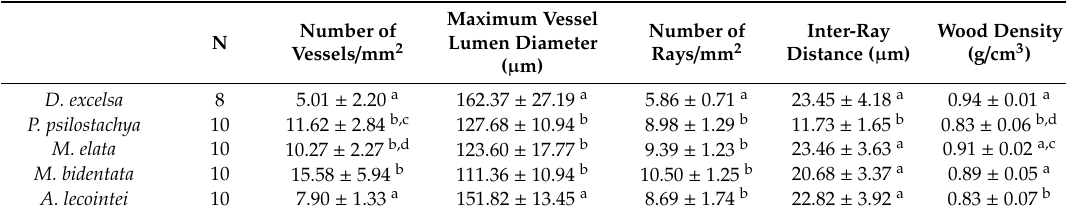
Table 2. Heartwood anatomical traits (mean ± SD) for the five tree species studied. Letters indicate differences at p < 0.05.